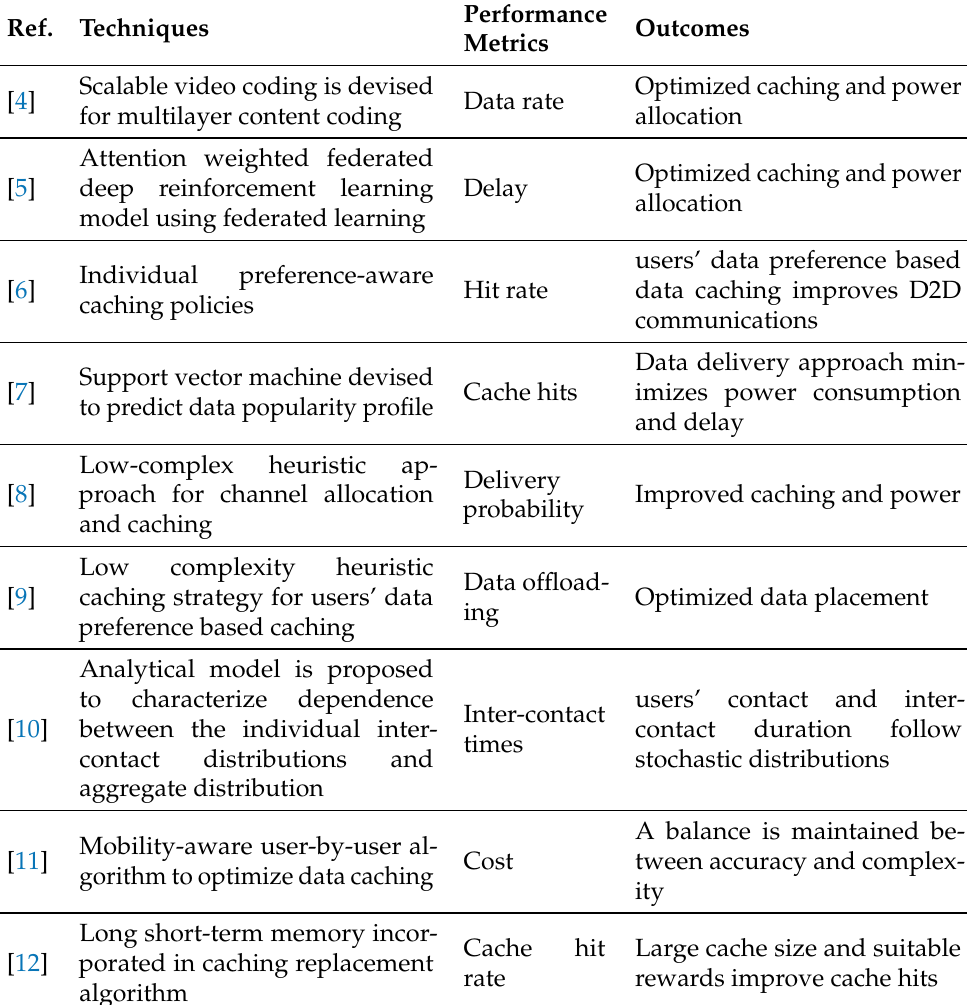
Table 1. A comparison of existing caching